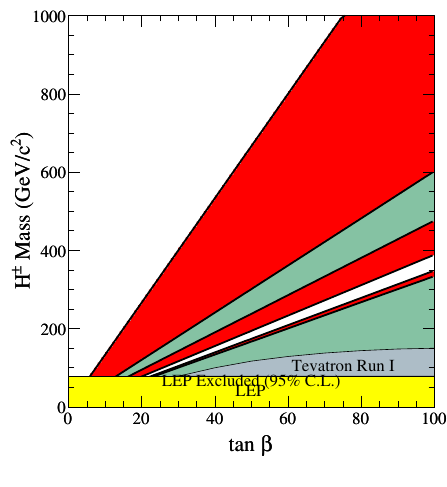
Figure 1. Five standard deviations discovery region (red) for the charged Higgs boson in the ( m H ± , tan β ) plane, from the measure- ment of B ( B + → τ + ν ) with 50 ab − 1 [9]. Other shaded regions show the current 95% C.L. exclusion